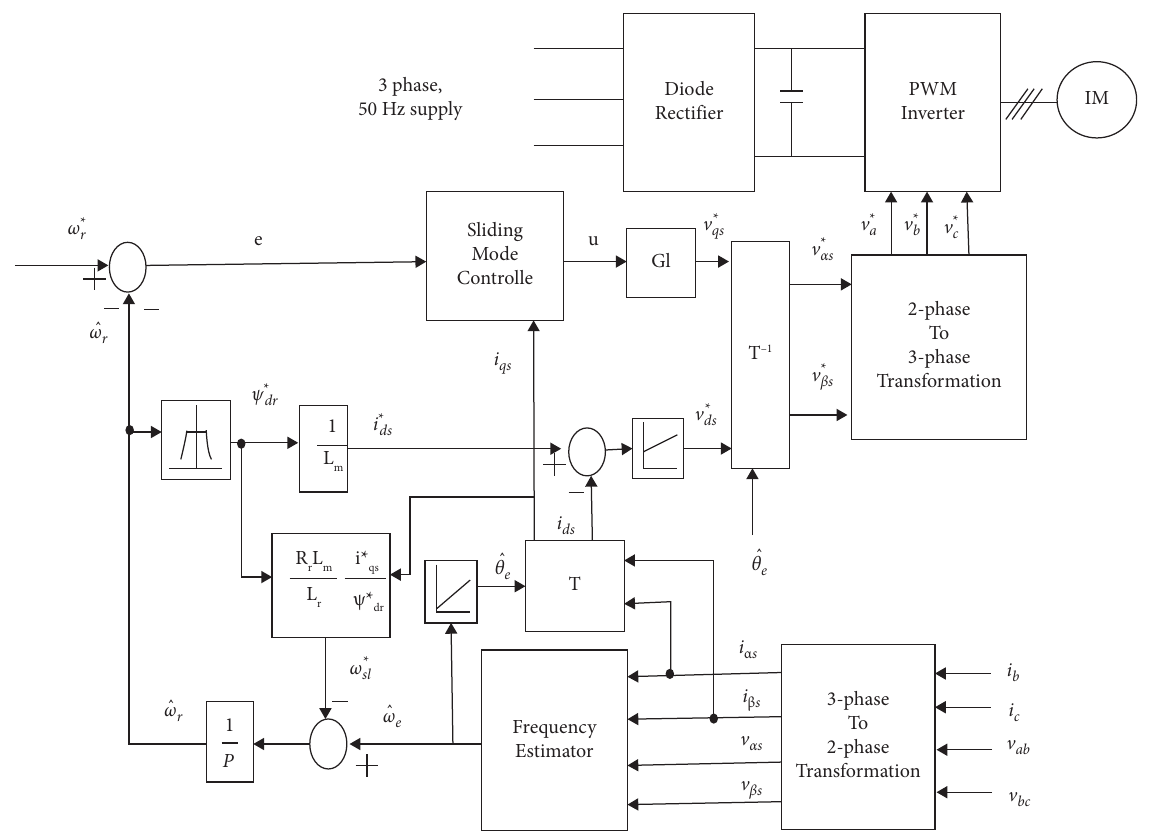
Figure 2: Sensorless speed control scheme for induction motor drive.